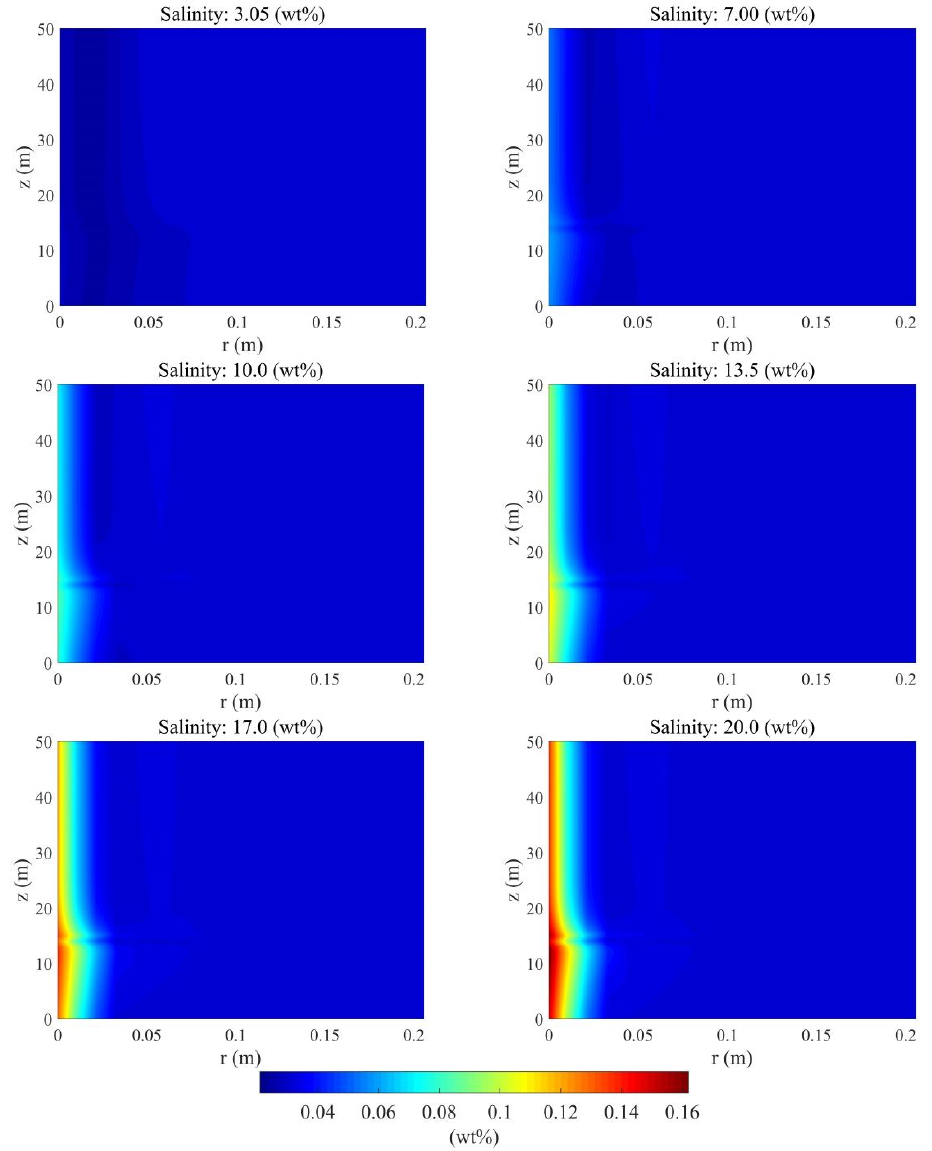
Figure 17. Comparison of two-dimensional salinity distribution of hydrate reservoirs for a fixed temperature of 16 °C at the 24th hour of drilling fluid invasion under various drilling fluid salinity values.